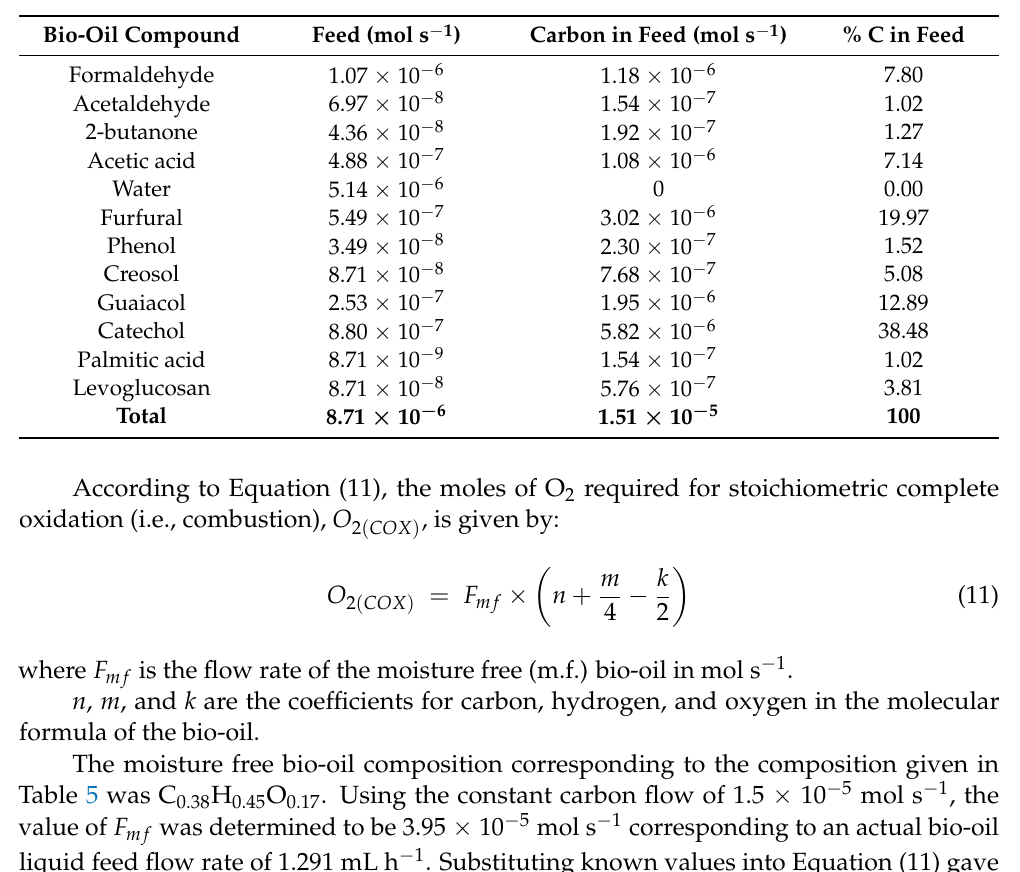
Table 5. Bio-oil surrogate feed component flow values used in Aspen Plus simulation and experi-